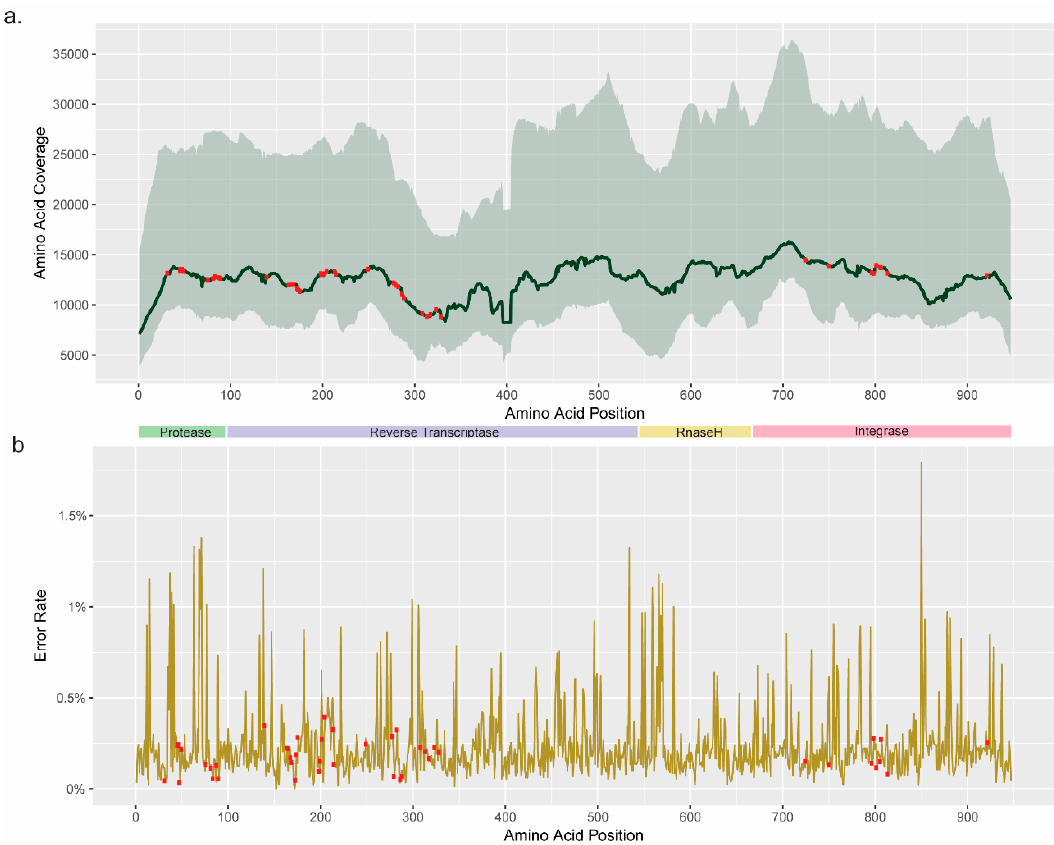
Figure 1. Coverage plot and error calculation: ( a ) The median coverage in each of the positions is indicated by the a dark green line. The light-green shade is the range of the coverage. ( b ) The error was calculated from the amino acid sequences of pMJ4 (NCBI# AF321523). Red dots indicate the drug resistance mutation (DRM) positions.